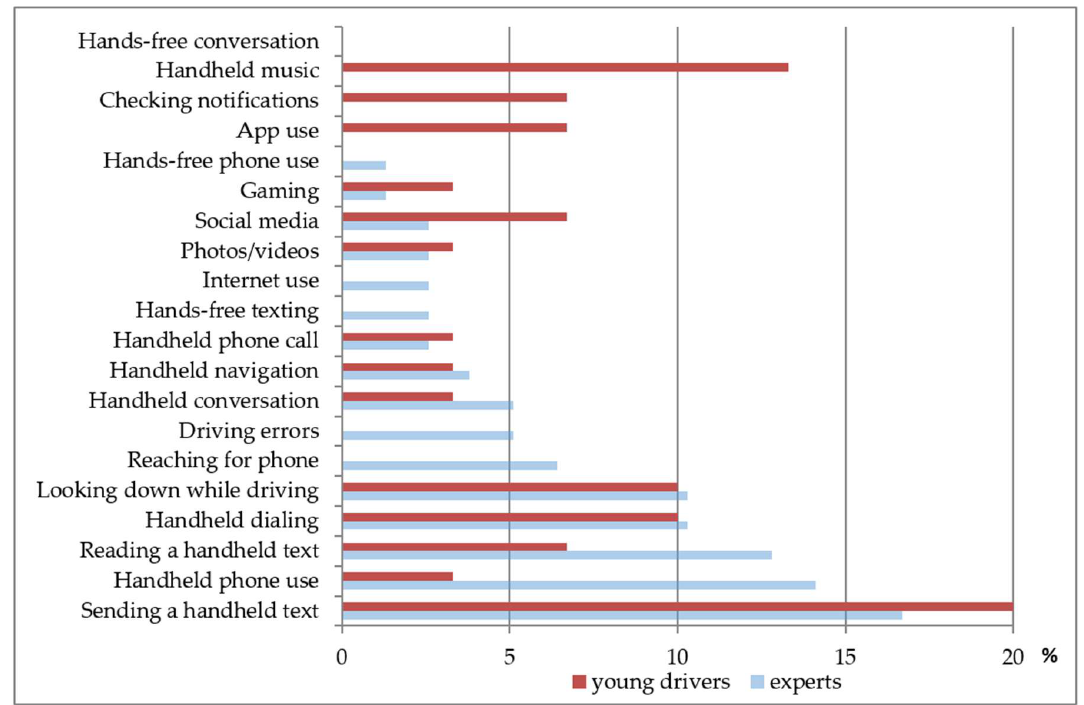
Figure 2. Behavioral indicators of cellphone use while driving presented as a percent of total possible responses from experts and young drivers, United States,